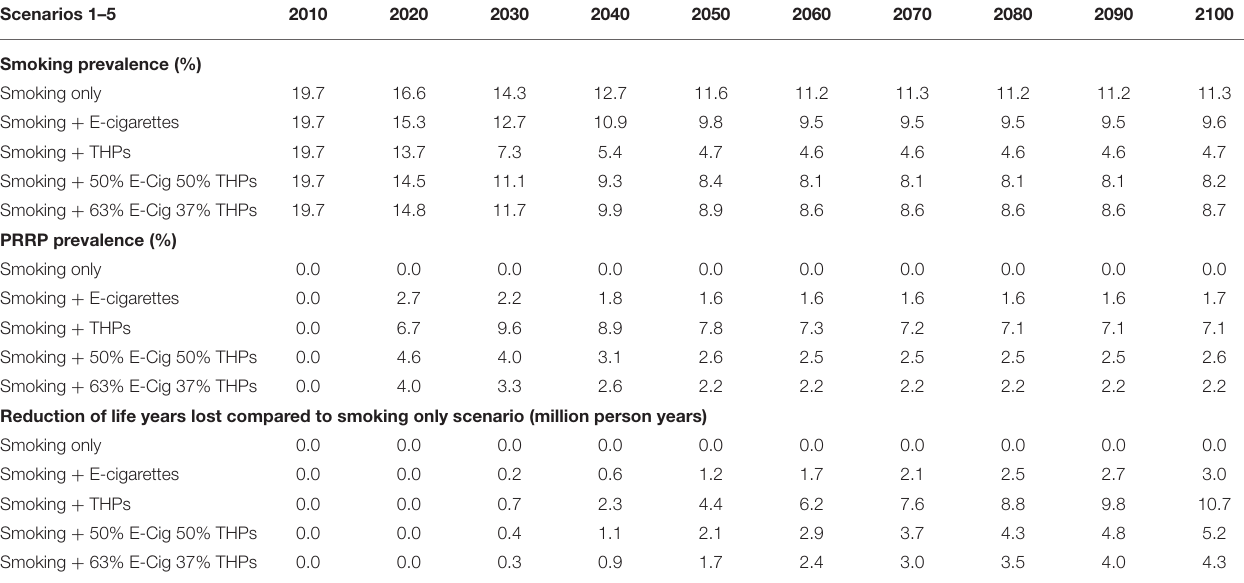
TABLE 4 | Projected prevalence and reduction of life years lost for scenarios 1–5. Scenarios